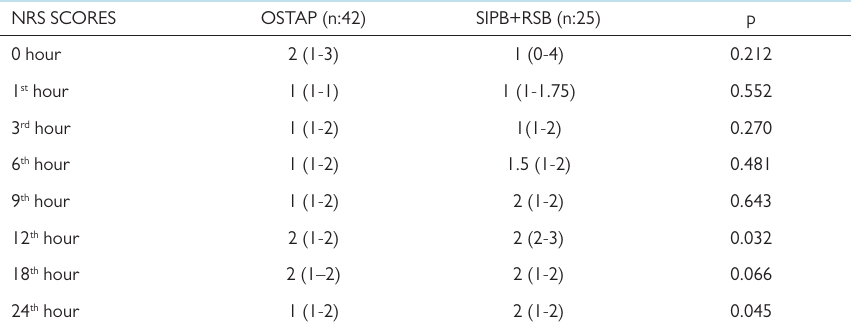
Table 2. Median NRS scores during rest and passive movement, for Group B and Group C at various time points of follow-up